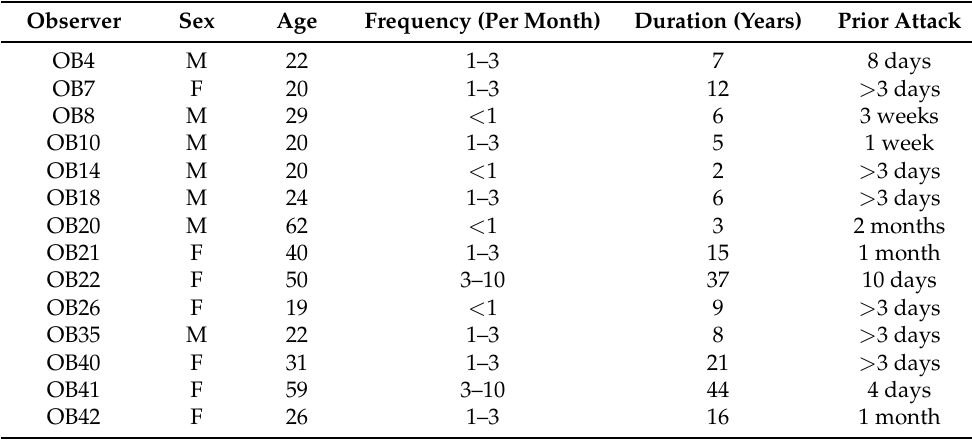
Table 1. Migraine with aura observers’ reports of clinical